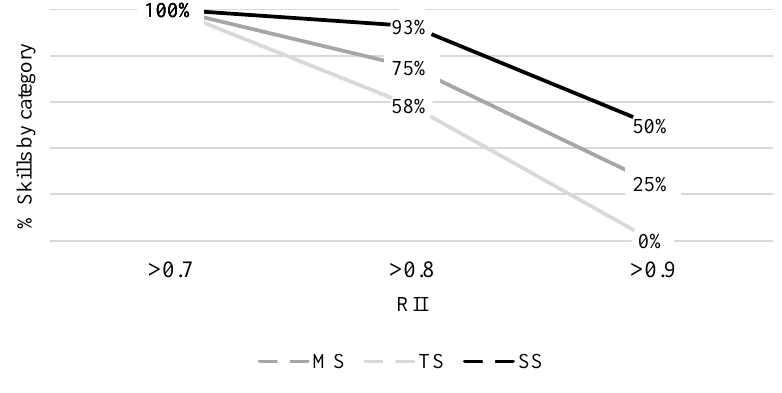
Fig. 5. Percentage of skills over an RII by